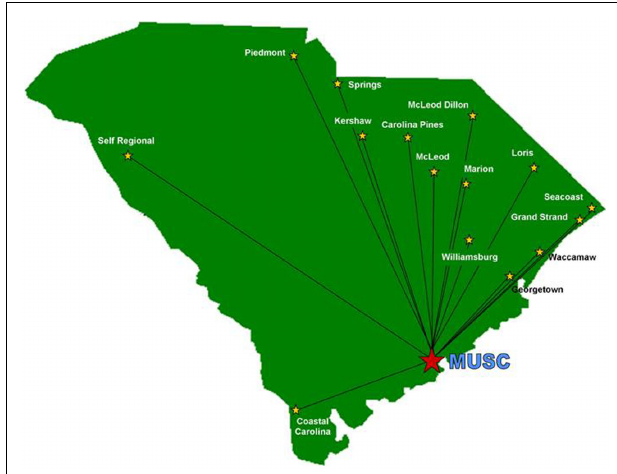
FIGURE 1 | REACH MUSC site map.